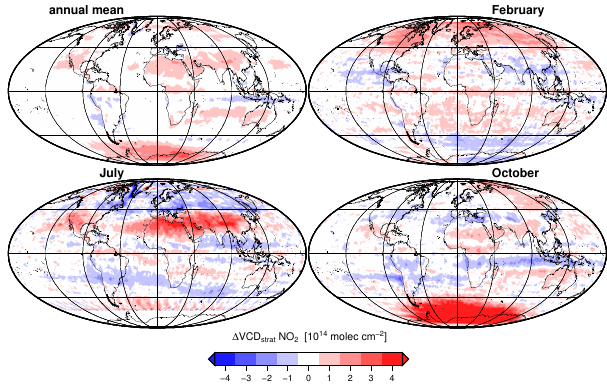
Fig. 9. The difference ∆VCD strat NO 2 between SCIAMACHY limb and Oslo CTM2 for the 2003–2007 time period. Red and blue areas correspond to regions where SCIAMACHY limb measurements are larger and smaller than Oslo CTM2 simulations, respectively. Top left: average difference over all months. Top right: average difference of all Februaries. Bottom left: average difference of all Julies. Bottom right: average difference of all Octobers. An additive offset has been applied to force the difference to equal zero over the reference sector (180 ◦ W–150 ◦